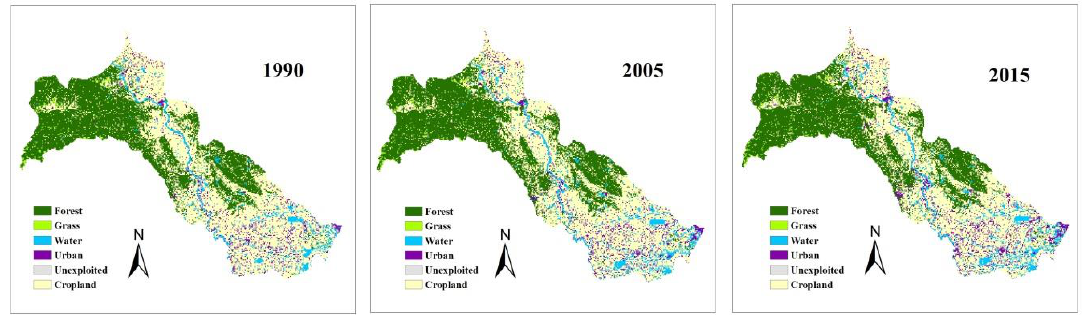
Figure 8. Land use map of the study area in 1990, 2005 and 2015. The dataset was obtained from the National Science & Technology Infrastructure of China, National Earth System Science Data Sharing Infrastructure (http://www.geodata.cn).